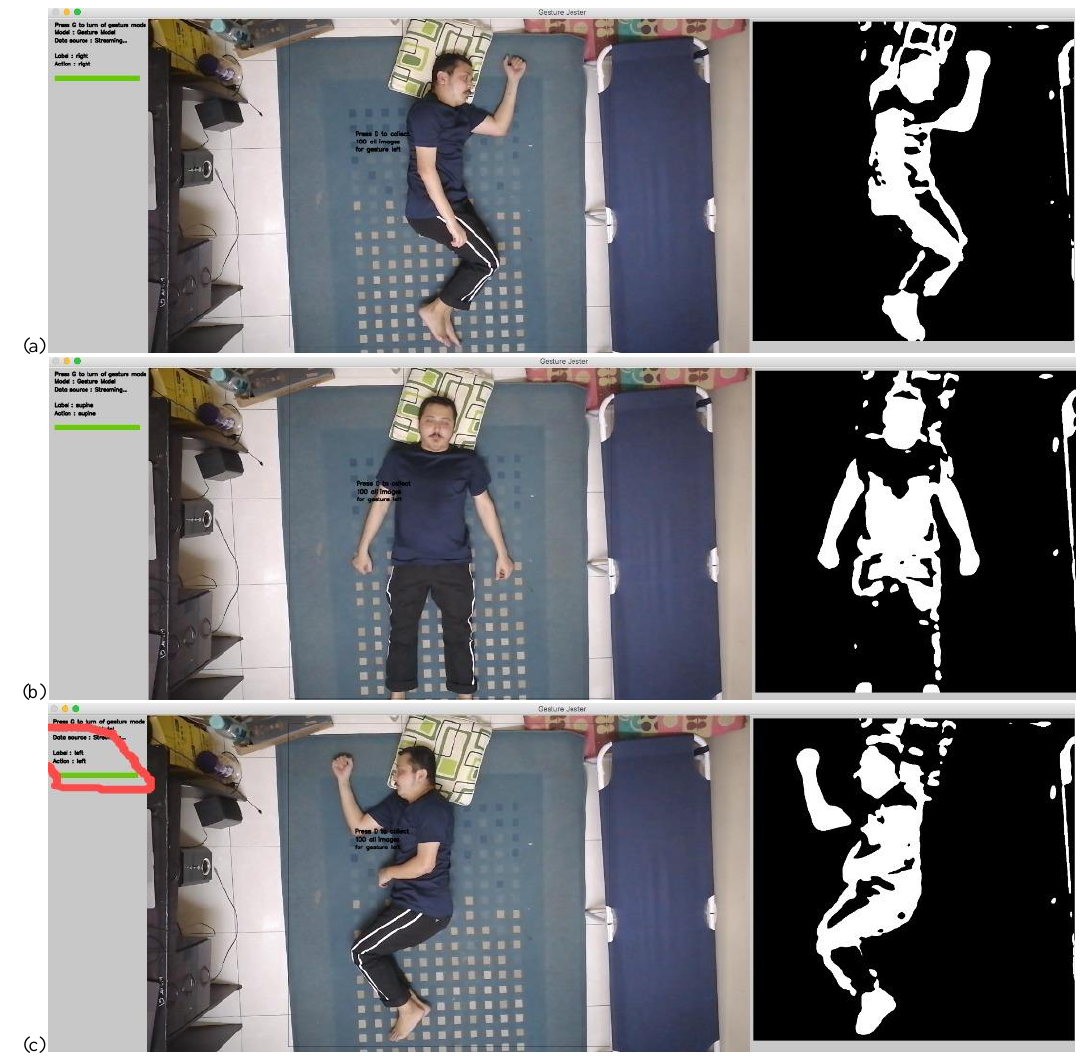
Figure 7. Snapshot of the real application using SleepCon trained model